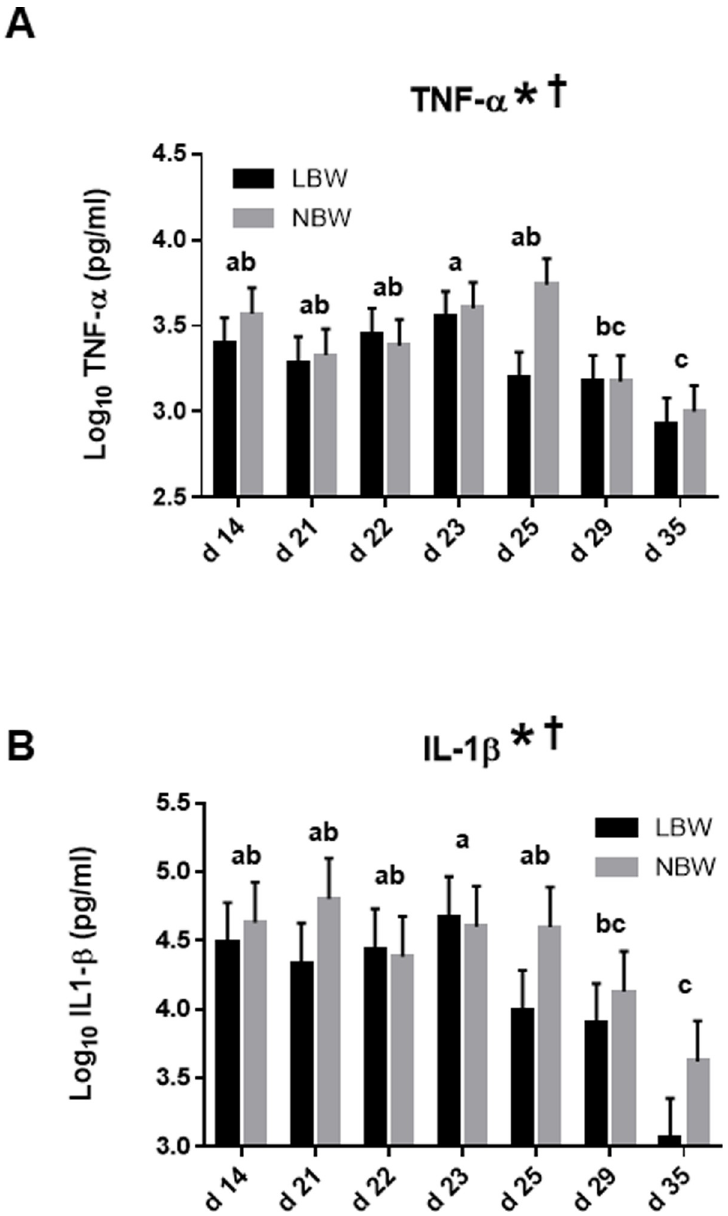
Fig 4. Levels of TNF- α and IL-1 β in plasma samples of LBW and NBW piglets of different ages throughout the peri-weaning period. Bars in the graphs represent Log 10 means ± SEM of 10 piglets of TNF- α (A) and IL-1 β (B) in plasma samples. Asterisk ( � ) indicates a significant effect of the age on means at P � 0.05. Dagger (†) indicates a significant effect of the birth weight on means at P � 0.05. Ages with different letters (a, b, c) within the graphs are statistically different at P � 0.05. Detailed P-Values for main effects and interactions are available in S15 Table in S1 File, comparative analysis with litter and gender as random cofactors in S16 Table in S1 File and box plot of data distribution in S5 Fig in S1 File. TNF- α = Tumor necrosis factor- α ; IL-1 β = Interleukin-1 β